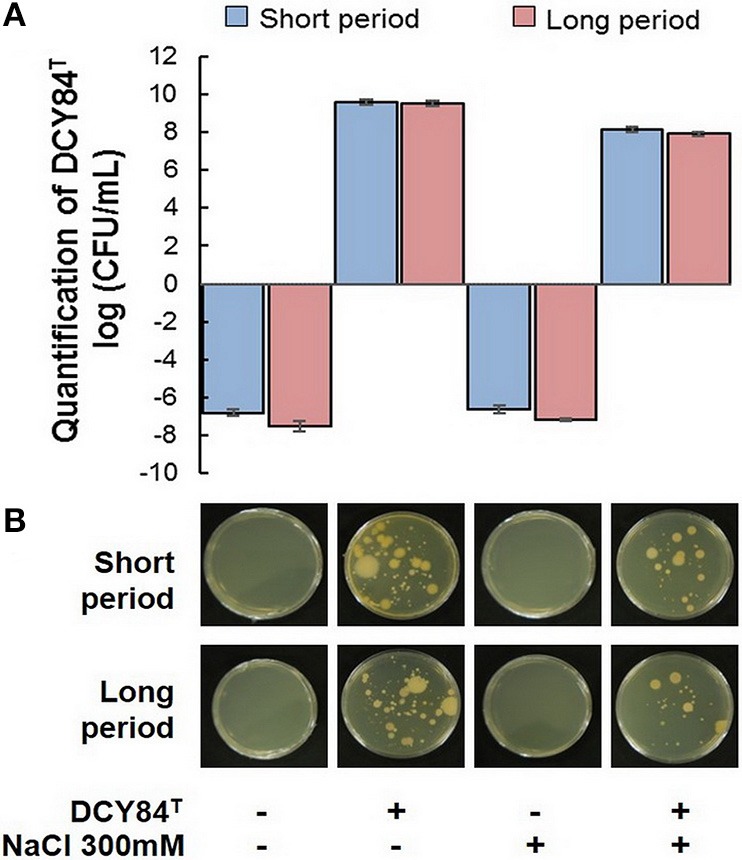
Monitoring of strain DCY84T in the P. ginseng rhizosphere. (A) Based on specific markers, DCY84T can be detected in a soil DNA sample. Although DCY84T was abundant, some bacterial contaminants were also present, as revealed by (B) plate streaking. The small colony with a white yellowish color is strain DCY84T (white arrow). The large colony with a yellow/white color is a bacterial contaminant.